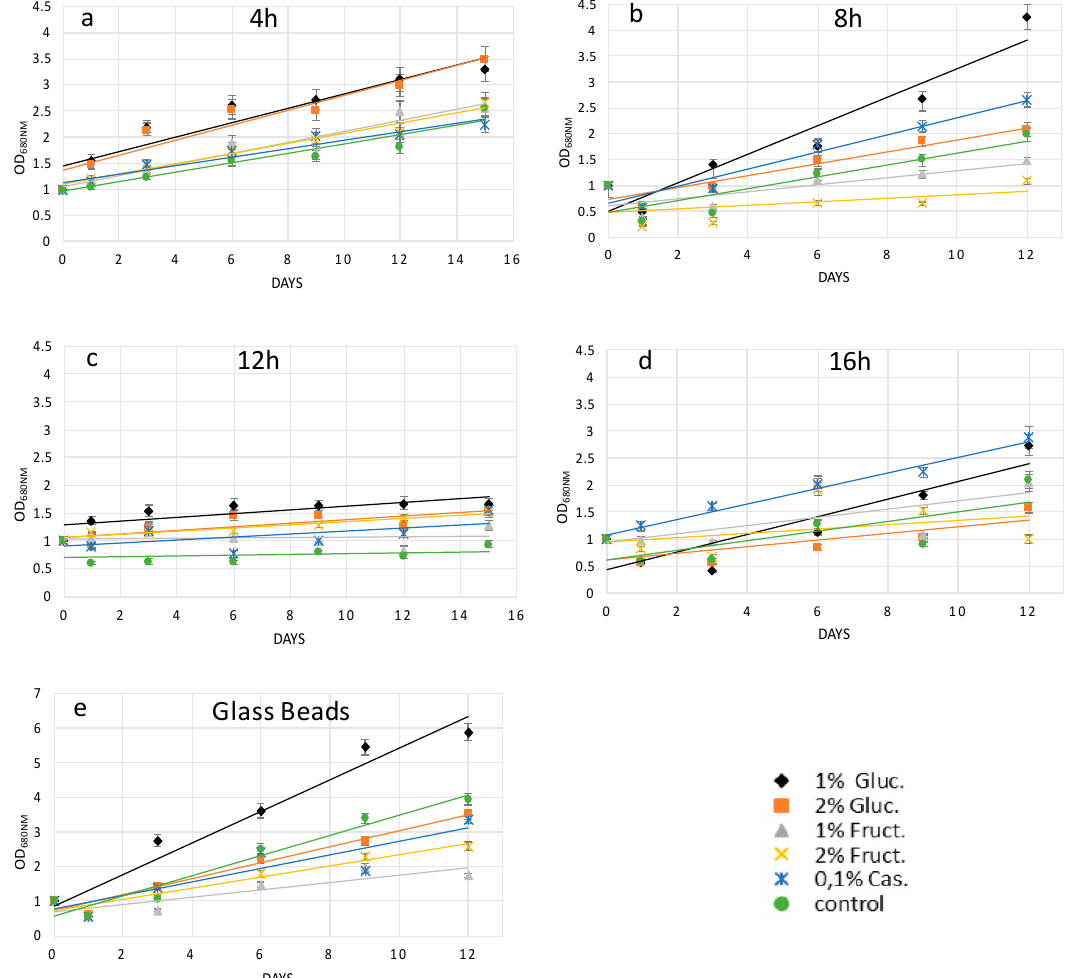
Figure 2. Recovery trend lines of H. pluvialis cells before and after enzymatic / mechanical treatment in media supplemented with an organic source of carbon ( a ) after 4 h of enzymatic hydrolysis; ( b ) after 8 h of enzymatic hydrolysis; ( c ) after 12 h of enzymatic hydrolysis; ( d ) after 16 h of enzymatic hydrolysis; ( e ) after mechanical treatment with glass beads. G.B. glass beads.